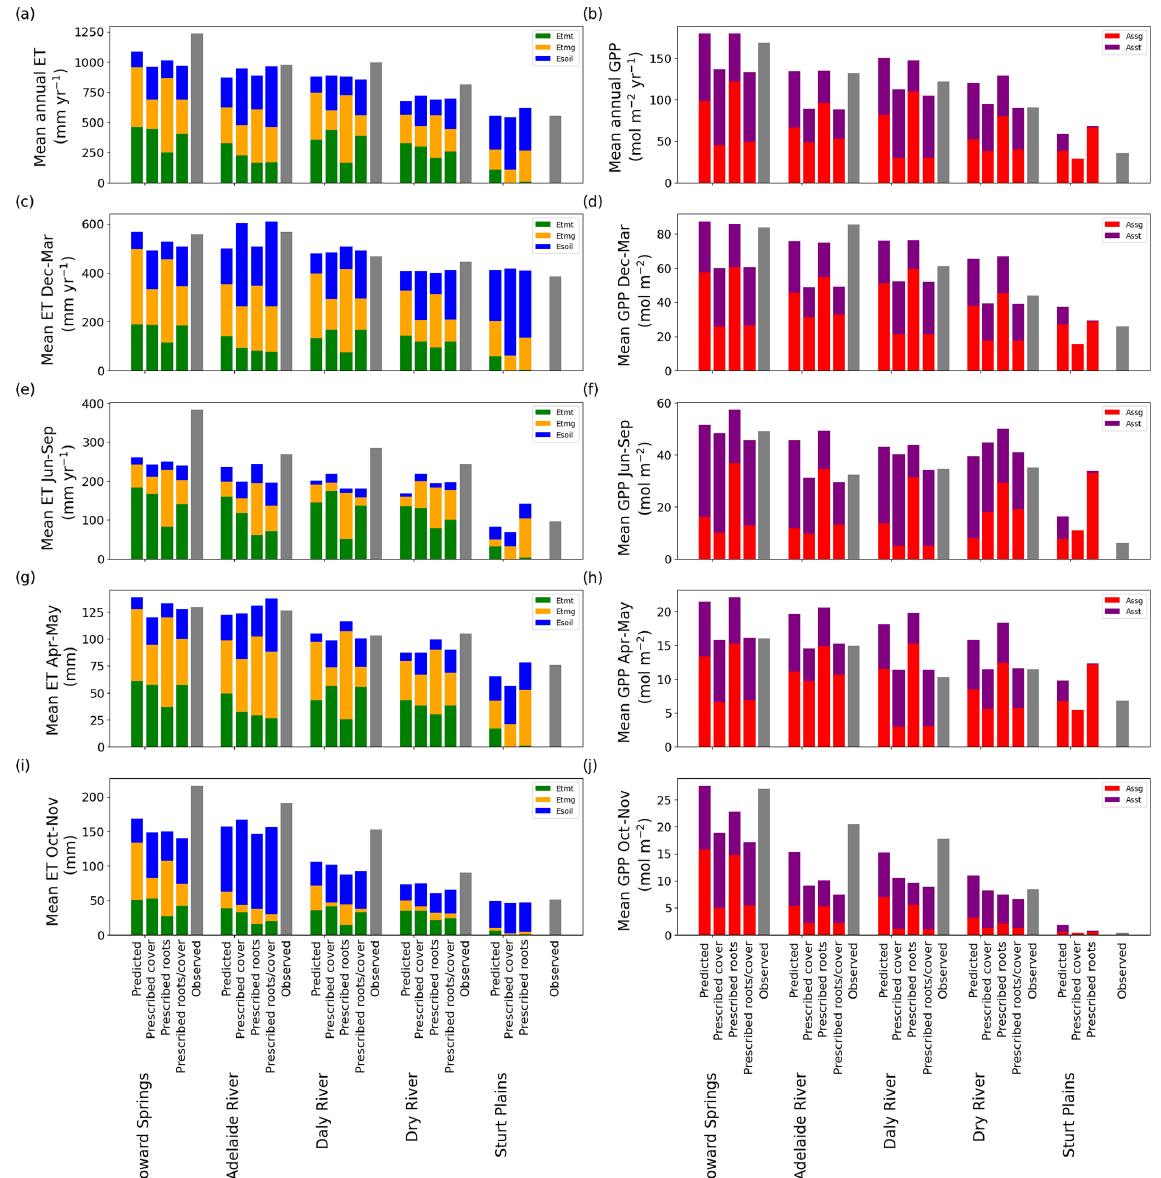
Figure 6. Observed and predicted fluxes of water and CO 2 using prognostic or prescribed cover, prescribed roots, or prescribed roots and cover at the different sites. Simulated ET was subdivided into soil evaporation (blue), tree transpiration (green) and grass transpiration (orange), while simulated GPP was subdivided into that of trees (purple) and grasses (red). Observations are shown as grey bars. Panels (c) and (d) represent the fluxes for December–March (generally the wet season), (e) and (f) the flux partition for June–September (i.e. generally the dry season), and (g) and (h) the fluxes for April–May (i.e. generally the transition from the wet to the dry season), and (i) and (j) the fluxes for October–November (i.e. generally the transition from the dry to the wet season). All metrics for all models are calculated for the overlapping time period of the model time period and the flux tower time period for each site (see Table S8.1 in Supplement